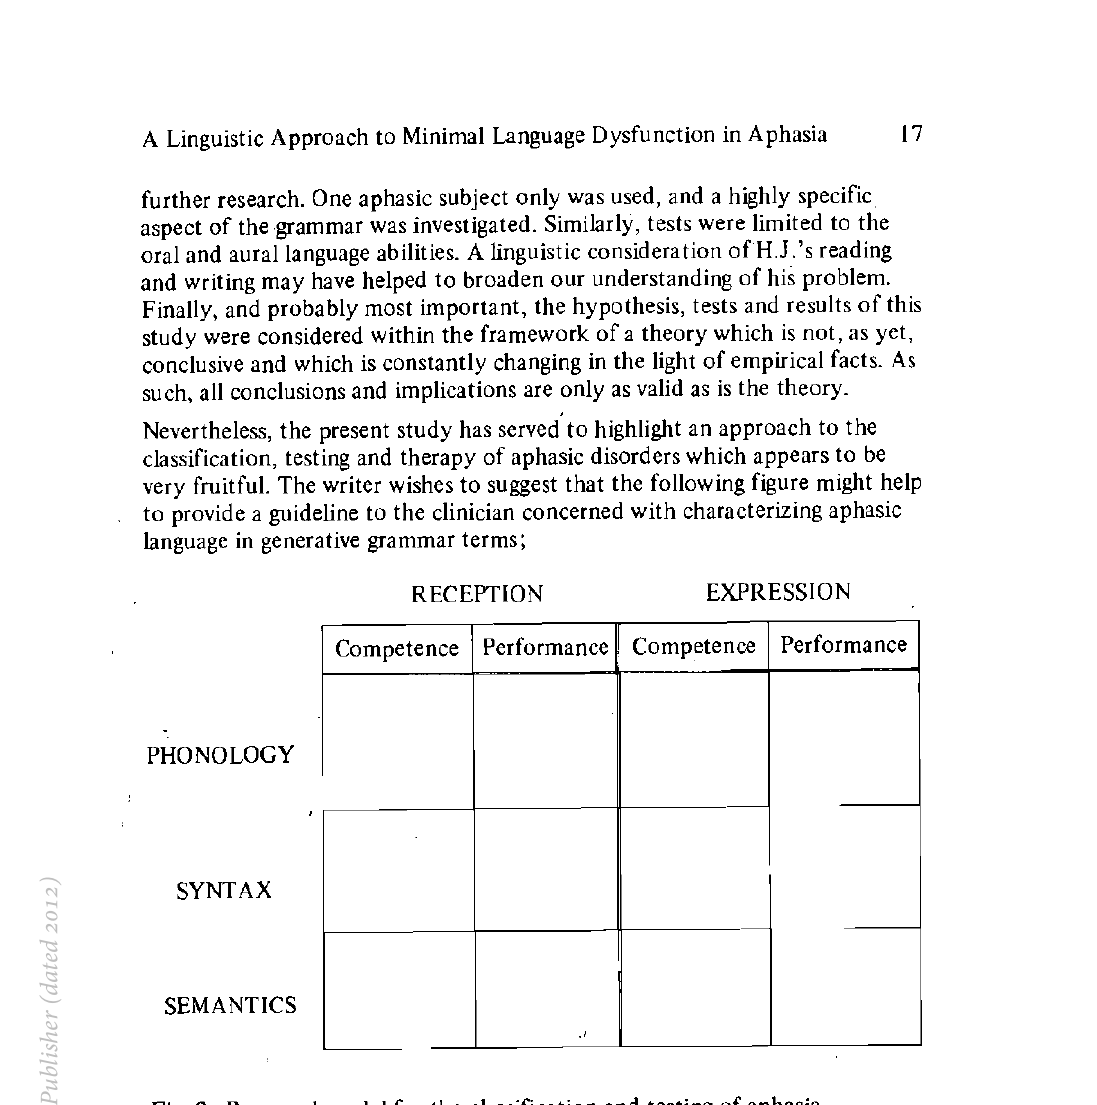
Fig. 2. Proposed model for the classification and testing of